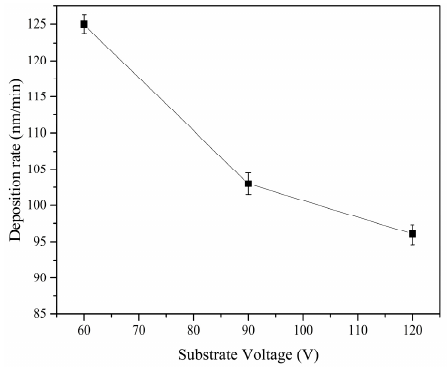
Figure 2. Coating deposition rates of CrN x coatings at various substrate biases.